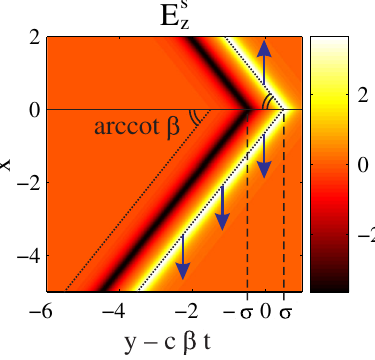
FIG. 3. The structure of the E z component of the surface wave in the plane of the grid for the “ rectangular ” bunch with q ¼ 1 esu. Gaussian units are used. The bunch length is 2 σ ¼ 1 cm; ~ κ ¼ 0 , δ ¼ 0 (the grid is a perfectly conducting plane in the x direction); a 0 ¼ 0 . 2 cm; β ¼ 0 . 8 , and z ¼ þ 0 . The solid blue arrows show the direction of the wave ’ s energy flow. Dashed lines are the straights parallel to y ¼ − β ðj x j − ct Þ